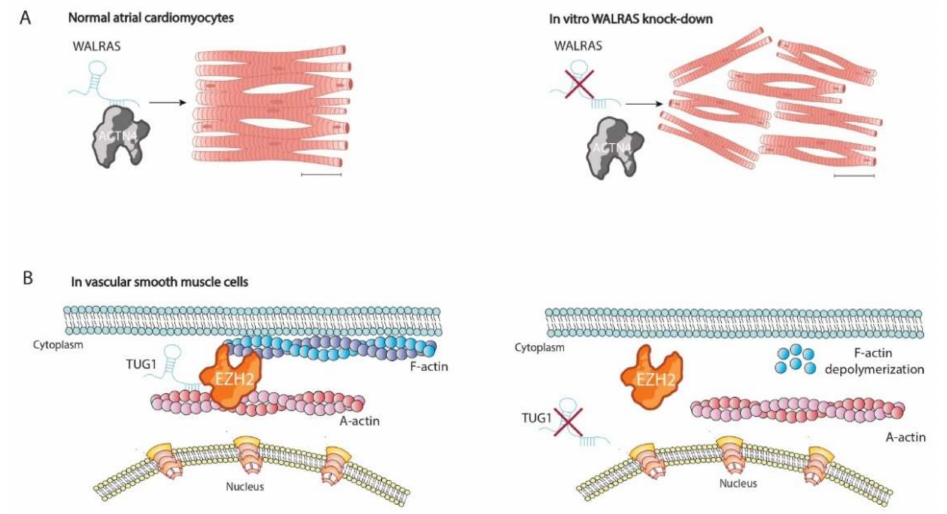
Figure 2. Schematic representation of cytoskeletal lncRNAs involved in cellular homeostasis. ( A ) Walras is required for the integrity of actin fibers in cardiomyocytes. ( B ) TUG1 modulates methylation of α -actin by EZH2 and therein is required for the formation of the cortex